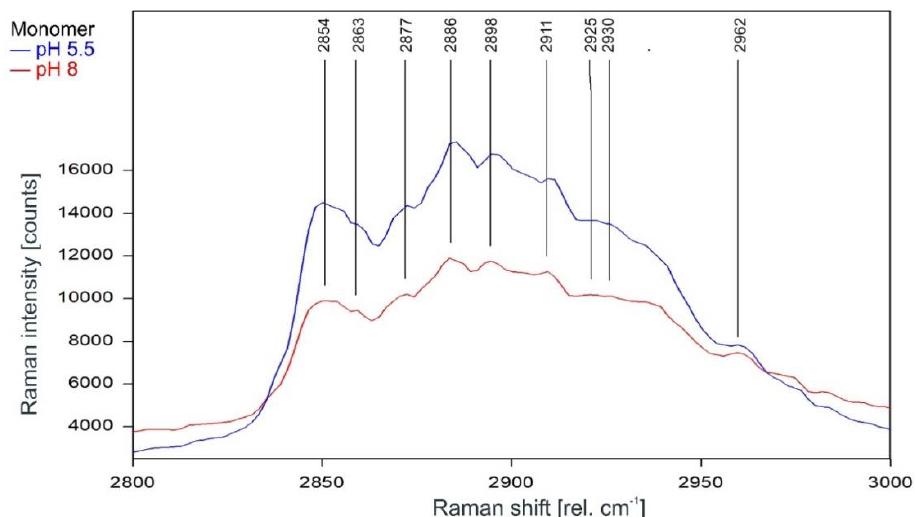
Figure 9. Raman spectrum of KcsA monomer between 2800 and 3000 rel. cm −1 at pH 5.5 (blue) and pH 8 (red) as recorded. Raman lines shared by the spectra are marked in black. A comparison of the spectra normalized to the area underneath for clarity is given in Figure 10.